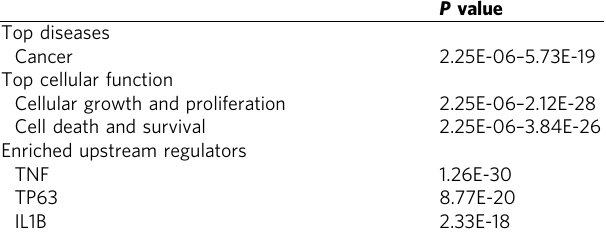
Table 4 Ingenuity pathway analysis (IPA) of the differentially expressed genes after knockout Jnk1/2 in MSCC LP.3 cells (Supplementary Data